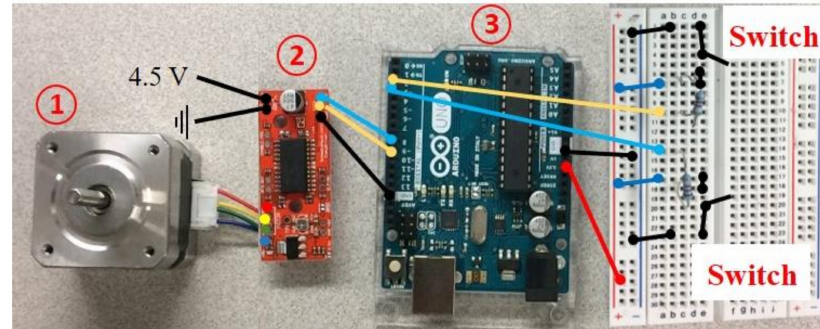
Figure 6. NEMA 17 motor setup.